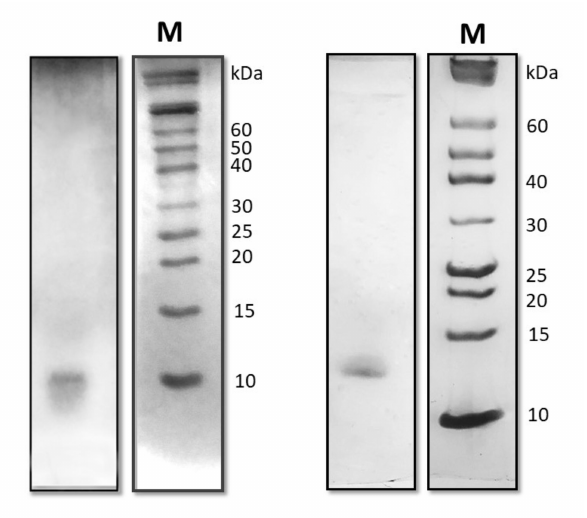
Figure 1. Silver stained SDS PAGE of proteins secreted by T. harzianum (left) and A. terreus (right) grown in the presence of 1% lampant oil as carbon source and 30 g / L NaCl (M: molecular weight